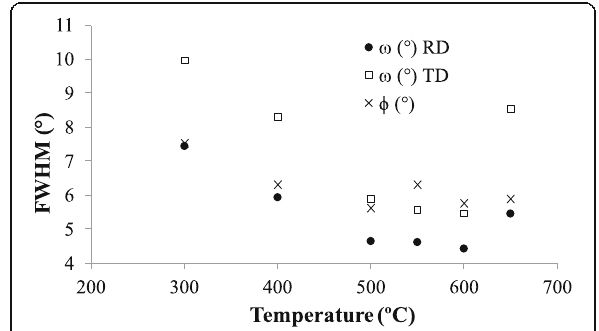
Fig. 3 FWHM of (200) RD and TD of ω -scans and (111) ϕ -scans for the (100) STO films deposited between 300 and 650 °C at laser frequency and chamber pressure of 10 Hz and 4 × 10 − 4 mbar,